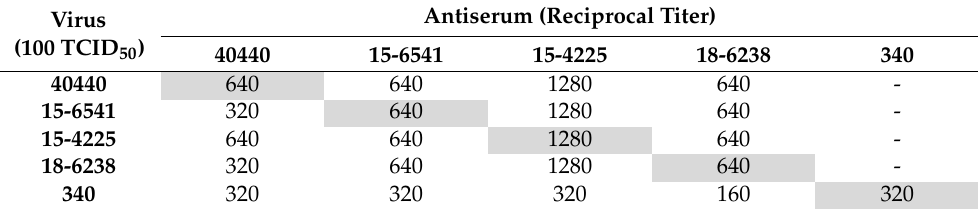
Table 4. Cross-neutralization testing between selected FAdV-B field isolates and the historical reference strain 340. The extent of neutralization is expressed as the reciprocal titer of antisera, standardized to 20 serum units against 100 TCID 50 of the homologous virus. Values highlighted in grey represent the homologous neutralization and the reference for all other reactions in the respective vertical column.